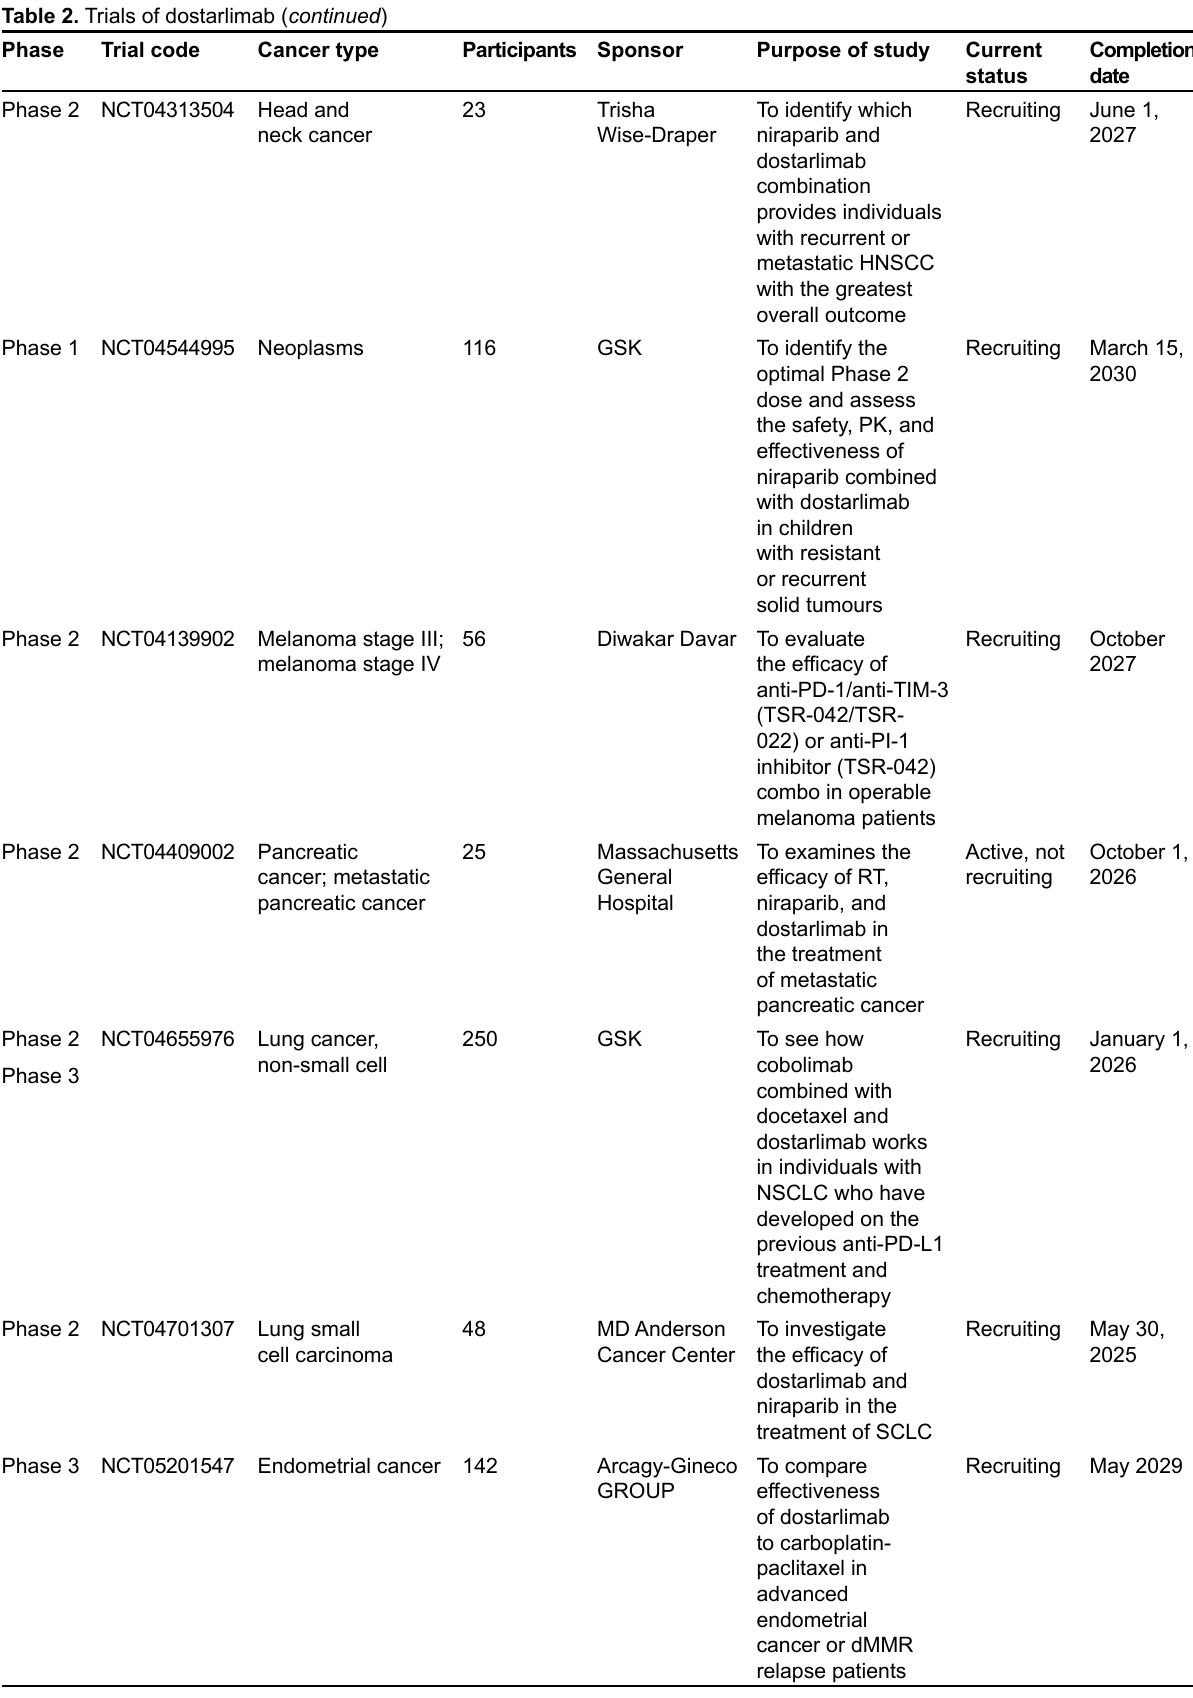
Table 2. Trials of dostarlimab ( continued